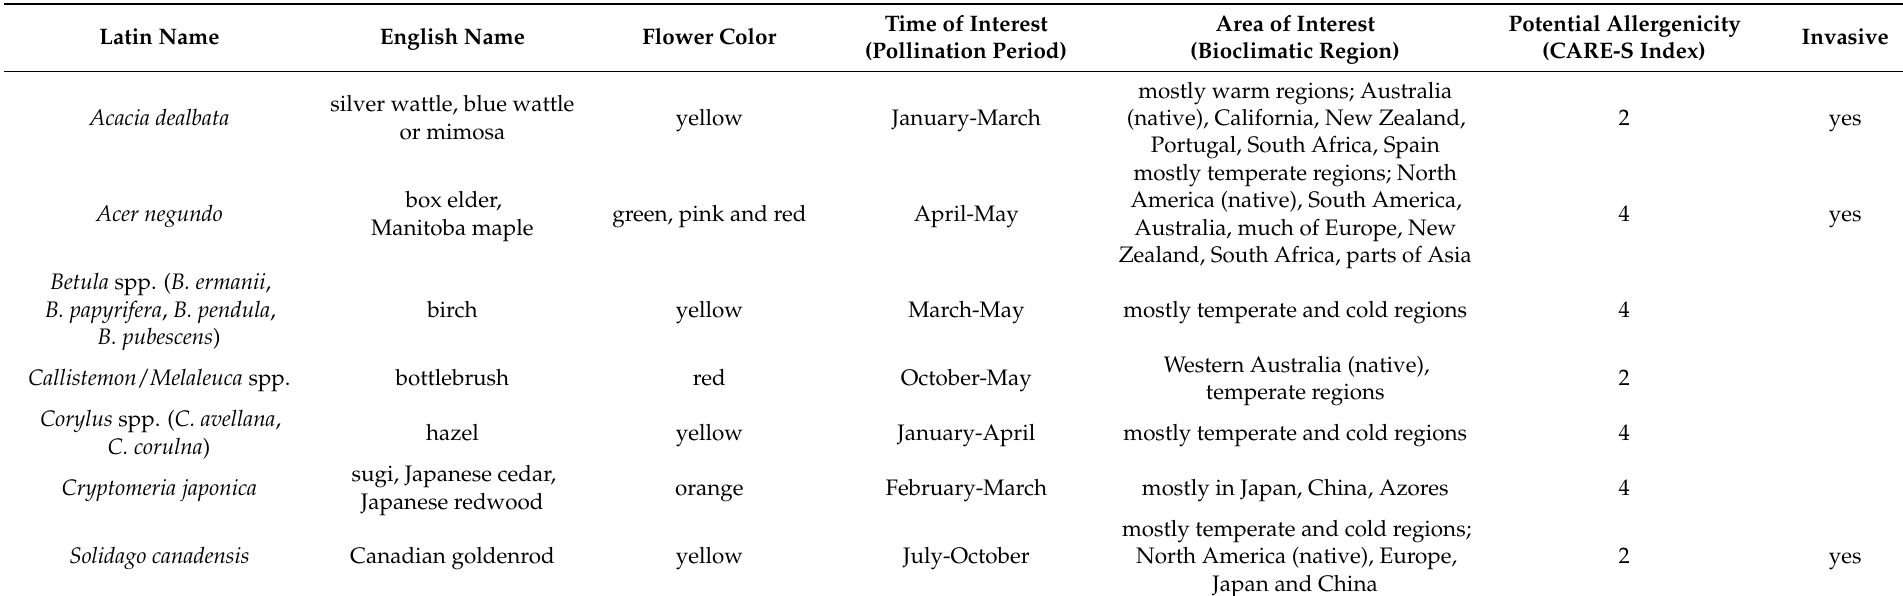
Table 3. Plant species recommended for illustrating visual marketing materials of allergy-related